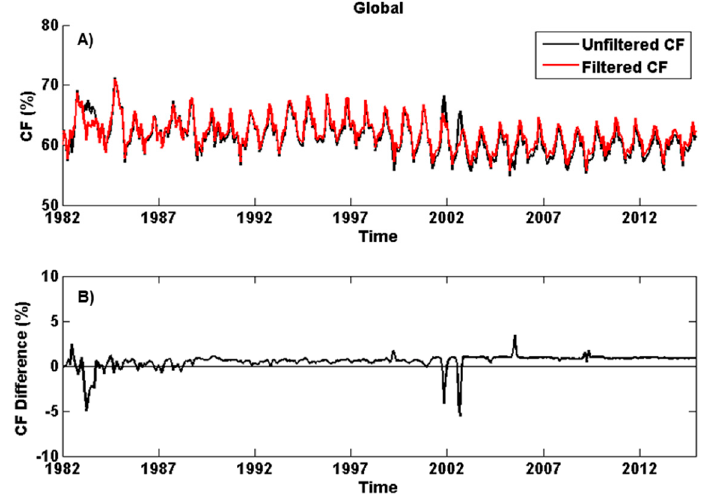
Figure 6. ( A ) global mean cloud fraction (% cloud cover) for the entire time period 1982–2015 for the final version of CLARA-A2 and the original CLARA-A2 version; ( B ) mean cloud fraction difference between filtered and unfiltered results. The impact of channel 3b filtering is visible in the period 1982–1999 (see text).